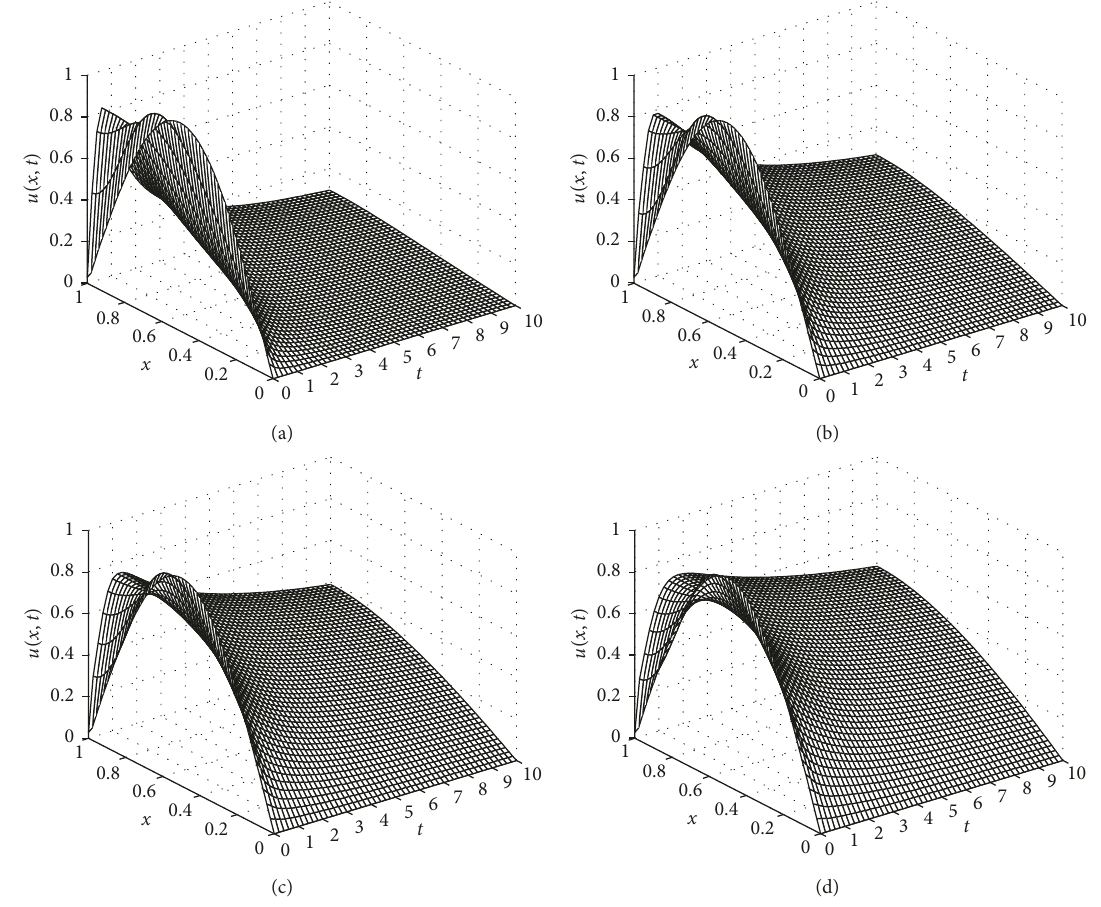
Figure 13: A 3D view of the dynamics of the MGKdVB equation utilizing the fourth nonlinear adaptive controller r � 0 . 4, and u ( x ) � sin ( π x ) . (a) α � 1; (b) α � 2; (c) α � 3; (d) α � 4. r 3 0